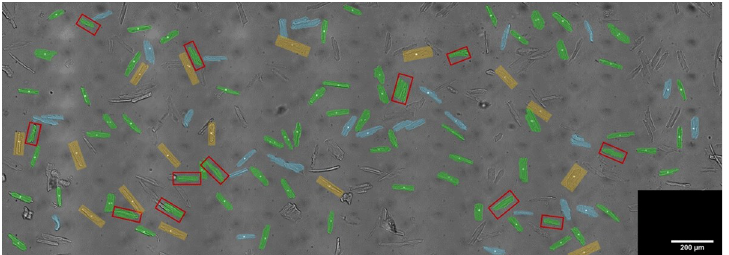
Fig 4. Validation result of 1 dish of rat cardiomyocytes. Image is a stitched and overlay view of 54 videos annotated manually (white dots) and found automatically by the algorithm (blue and green overlay i.e. True Positives). Blue overlay indicates cells which were filtered out for measurement based on a low SNR of the FFT signal. Red box indicates cells which were found by the software, but not annotated manually i.e. False Positives. Yellow boxes indicate cells that were annotated manually but not found by the algorithm i.e. False